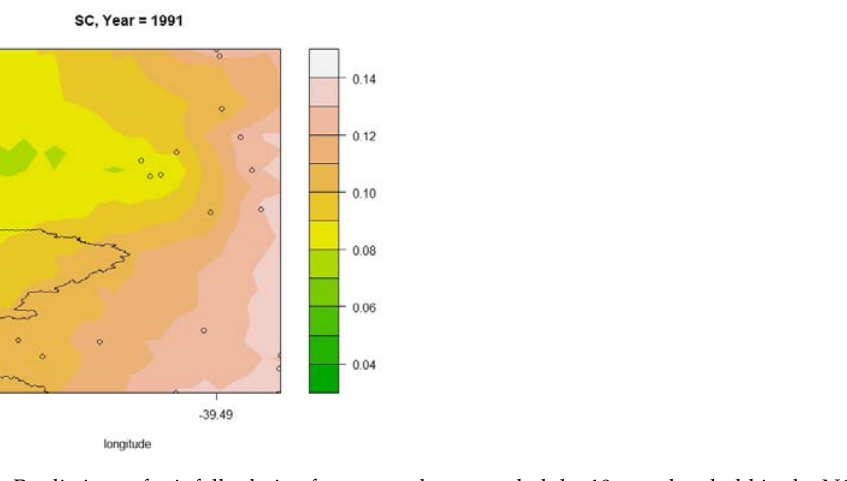
Figure 2. Predictions of rainfall relative frequency that exceeded the 10 mm threshold in the NC, NS, NO, SS and SC regions in 1991. Table 1. Posterior mean, median and 95% credibility interval for the parameters β , α , φ , σ 2 and Ψ (cid:48) = ( Ψ 0 , Ψ 1 , Ψ 2 ) ( Ψ 0 is the intercept, Ψ 1 is the coefficient associated with longitude and Ψ 2 is the coefficient associated with latitude) of the model adjusted for an estimate of the R10 mm index in the NC, NS, NO, SS and SC regions.